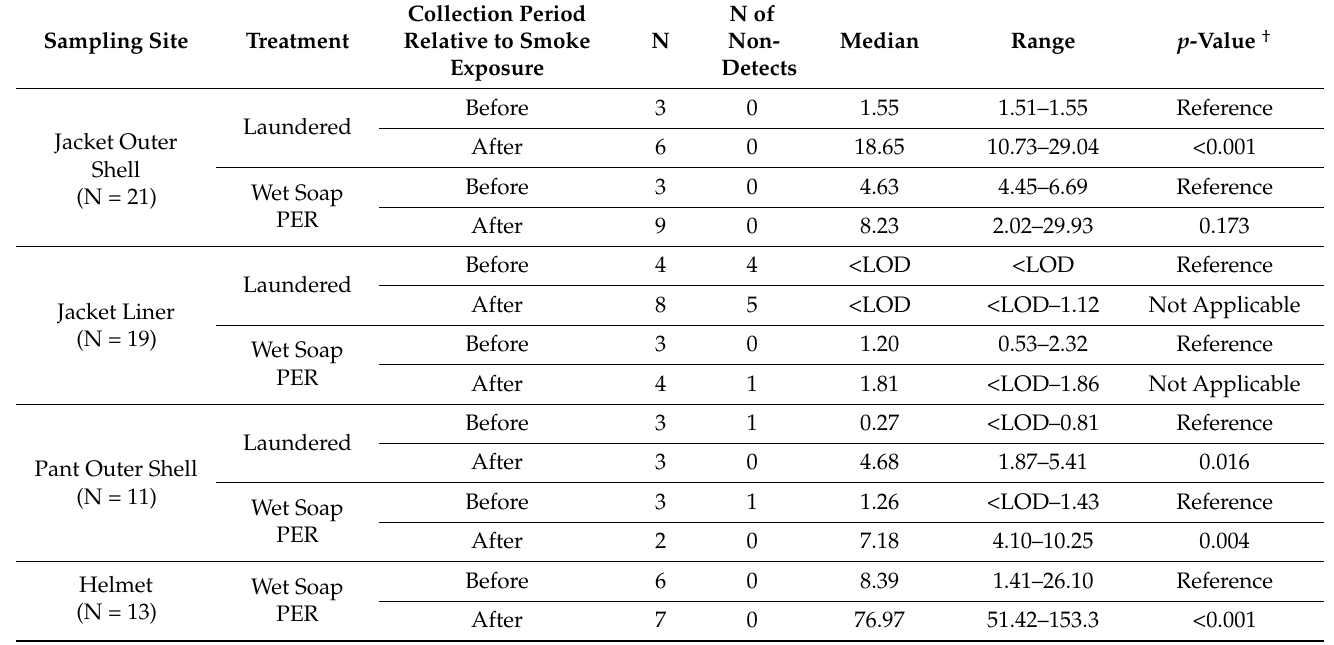
Table 1. Median total PAH concentration ( µ g/100 cm 2 ) on two consecutive wipes of firefighter gear after repeated exposures and cleanings